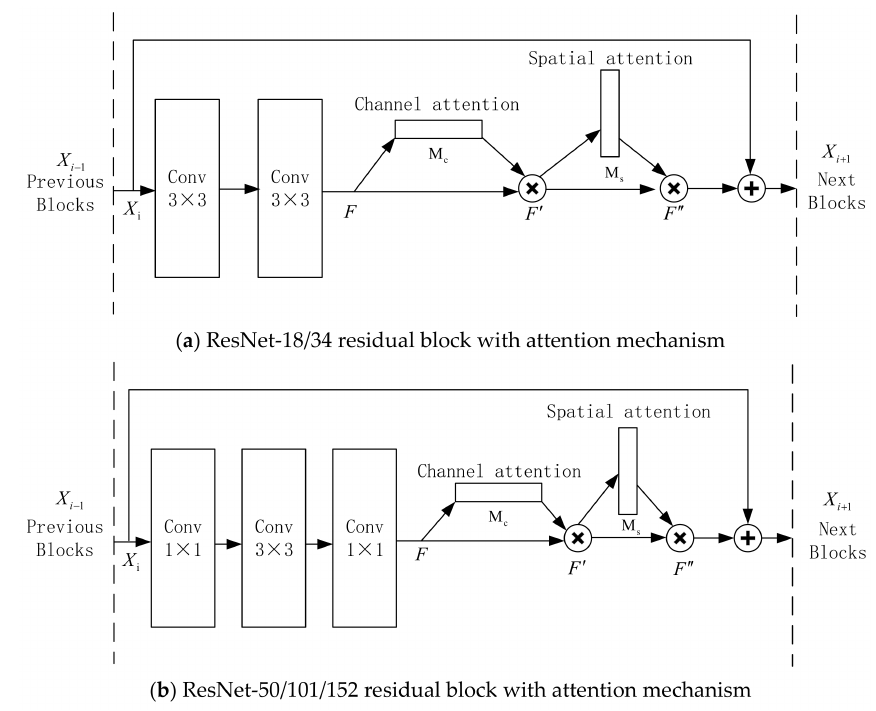
Figure 2. Residual blocks with an attention